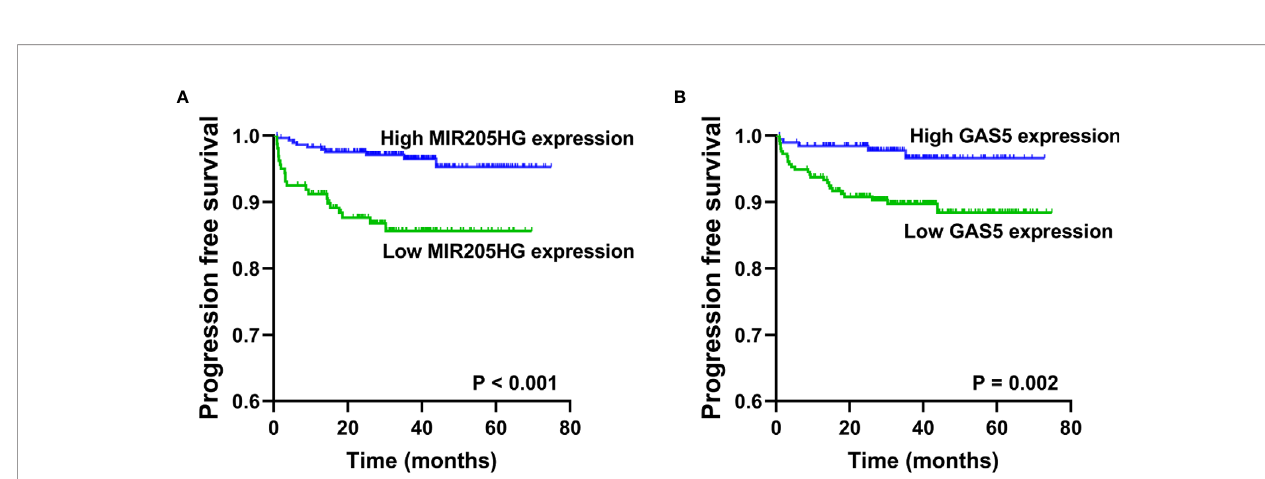
FIGURE 9 | Validation of the prognostic of MIR205HG and GAS5 in NMIBC. Kaplan-Meier curves revealed that low expression of MIR205HG (A) and GAS5 (B) in tumor tissues were relative to a poor progression free survival in NMIBC patients from Hedegaard et al.